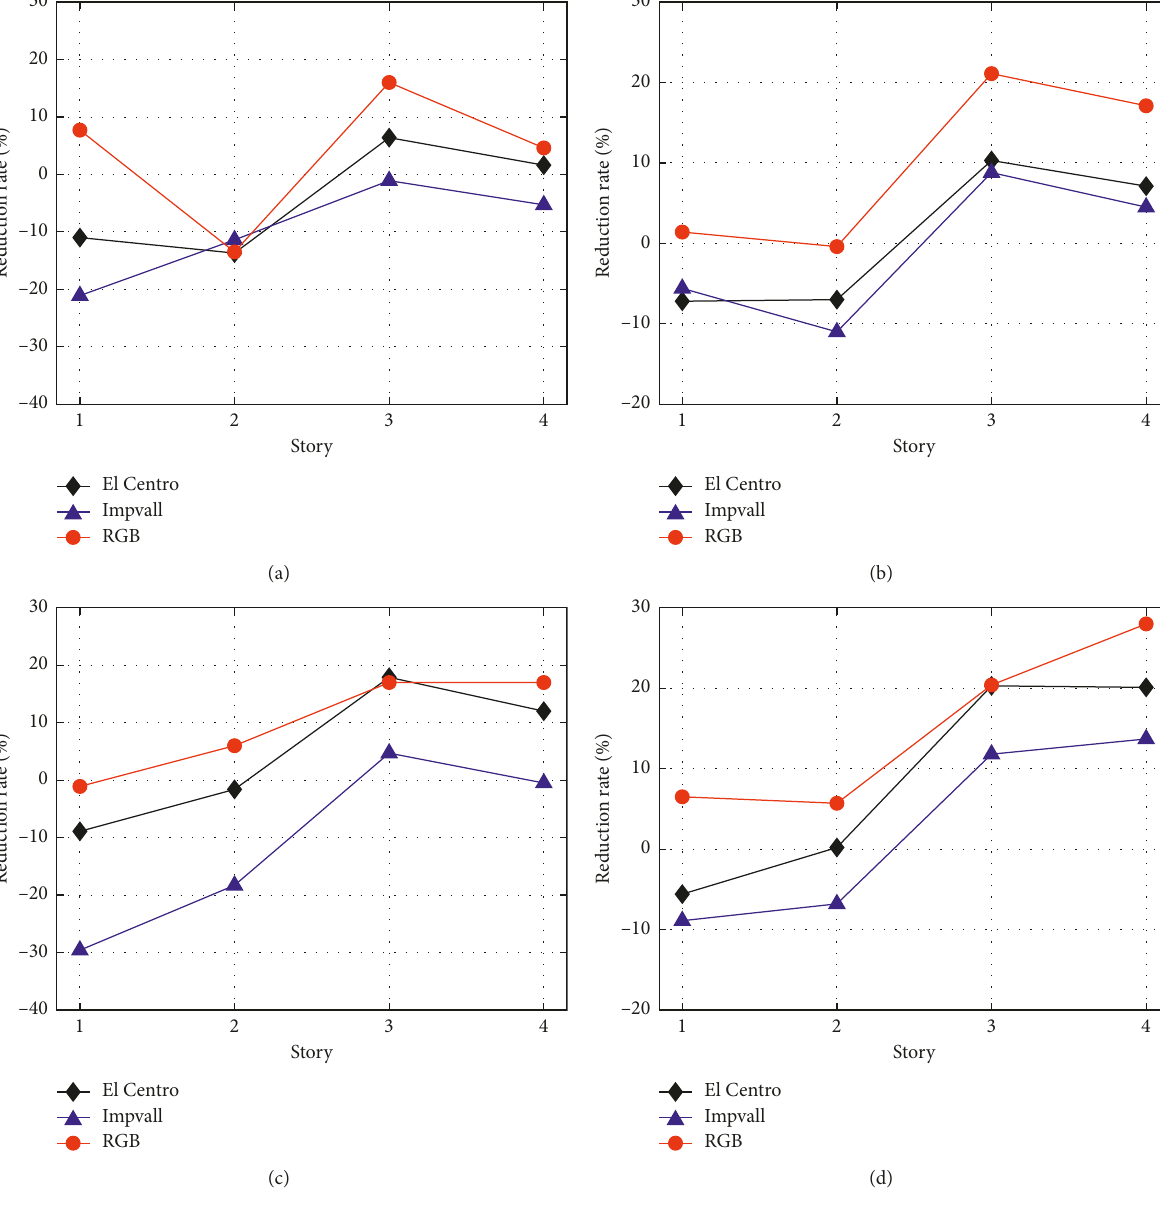
Figure 15: Acceleration reduction rates under frequent- and moderate-intensity earthquake conditions. Peak reduction rate of acceleration under (a) frequent-intensity earthquake conditions and (c) moderate-intensity earthquake conditions. RMS reduction rate of acceleration under (b) frequent-intensity earthquake conditions and (d) moderate-intensity earthquake